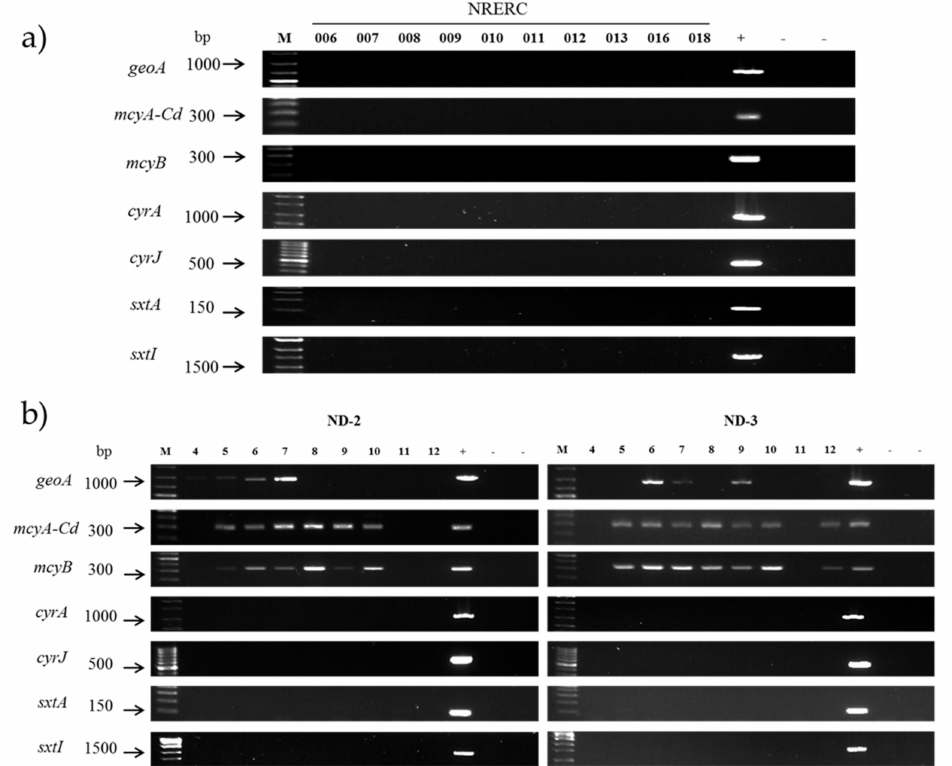
Figure 5. Gel electrophoresis image of the PCR products of the geosmin ( geoA ), microcystin ( mcyA-Cd , mcyB ), saxitoxin ( sxtA , sxtI ), and cylindrospermopsin ( cyrA , cyrJ ) biosynthesis genes from ( a ) Aphanizomenon flos-aquae isolates (NRERC–006 to NRERC–018) and ( b ) water samples. Sample number of ND-2 and ND-3 indicates the month of sampling date (Table 3). Positive (+) and negative ( − ) controls for each gene are described in the Materials and Methods section. M indicates SiZer-100 DNA